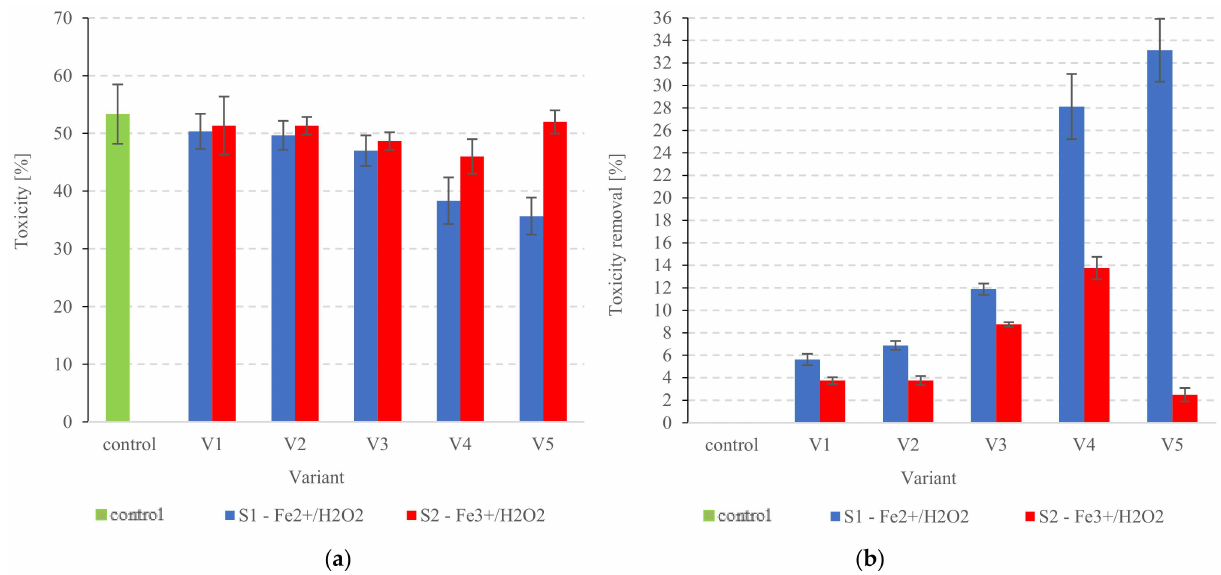
Figure 3. Toxicity after pre-treatment ( a ) changes in PSS, ( b )